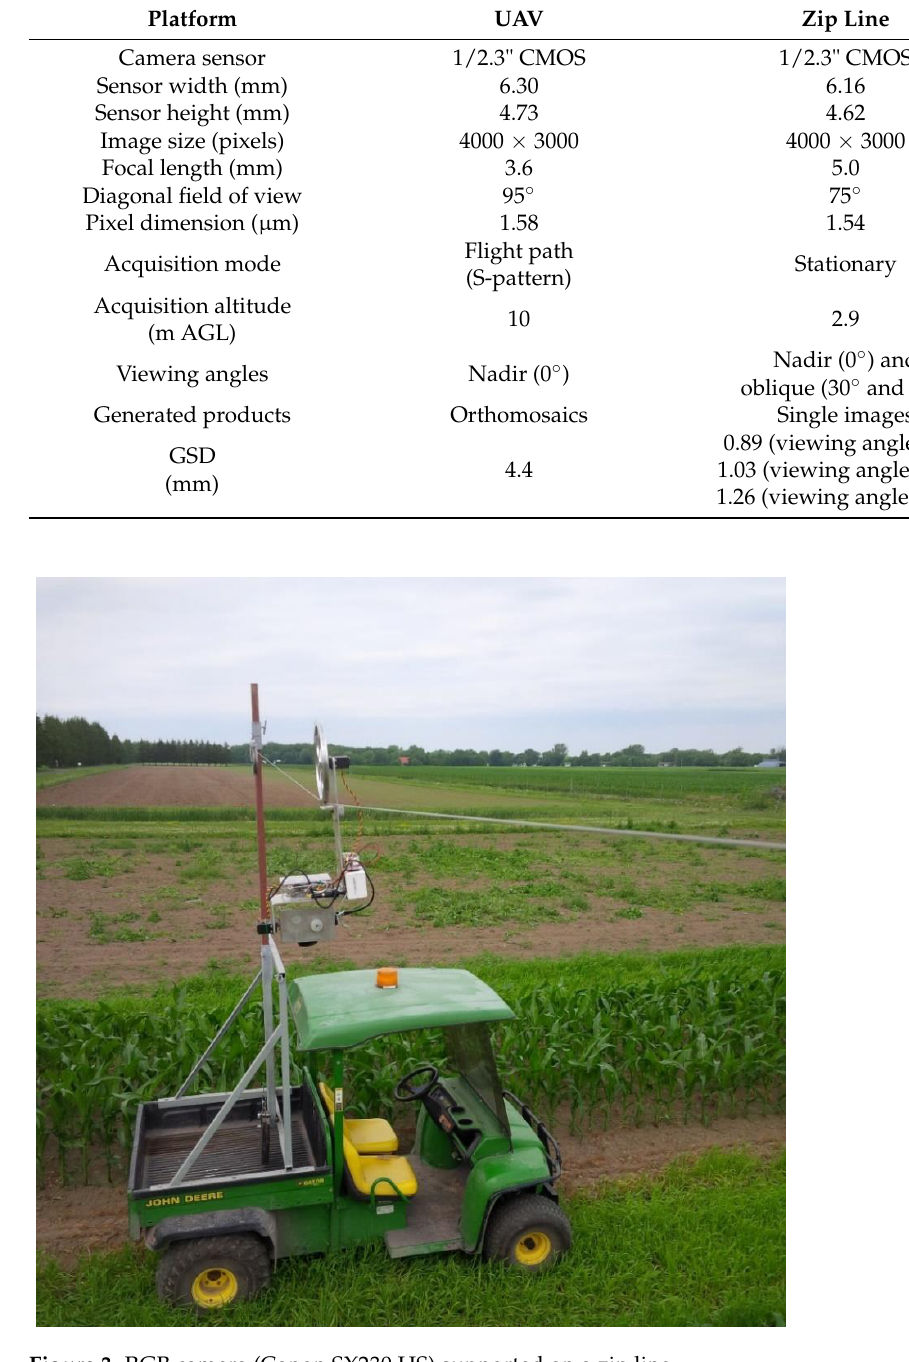
Figure 3. RGB camera (Canon SX230 HS) supported on a zip